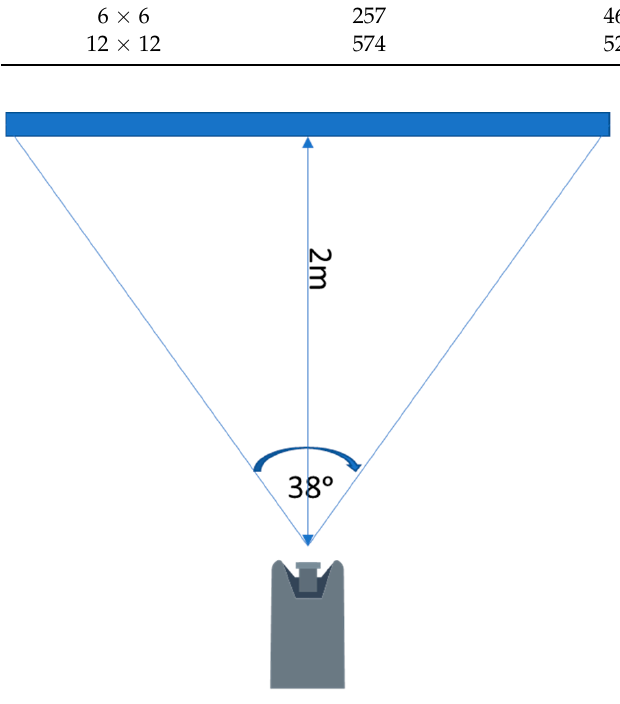
Figure 4. Effective camera field of view.